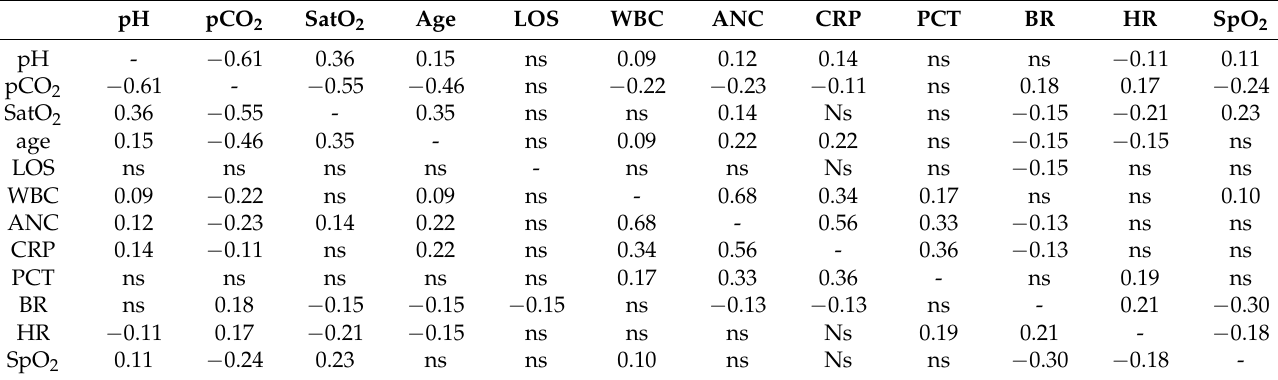
Table 3. The matrix of correlation (Spearmann’s rank correlation coefficients rho are shown; ns—statistically non-significant). pH pCO 2 SatO